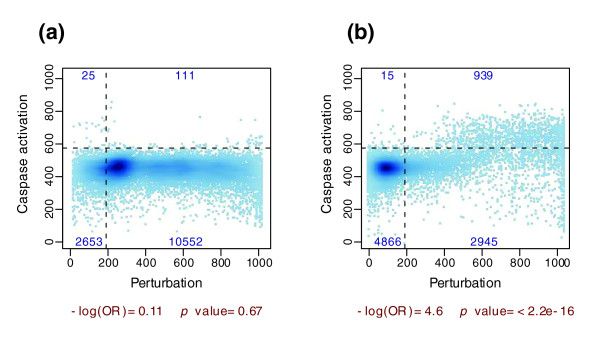
Example results for binary response-type assays from a screen targeting apoptosis regulation. Cell counts for the respective quadrants are indicated on the edges of the plots. (a) Non-affector (YFP), with effect size close to zero and insignificant P value. (b) Activator (Fas receptor), with both large effect size and significant P value. OR, odds ratio.